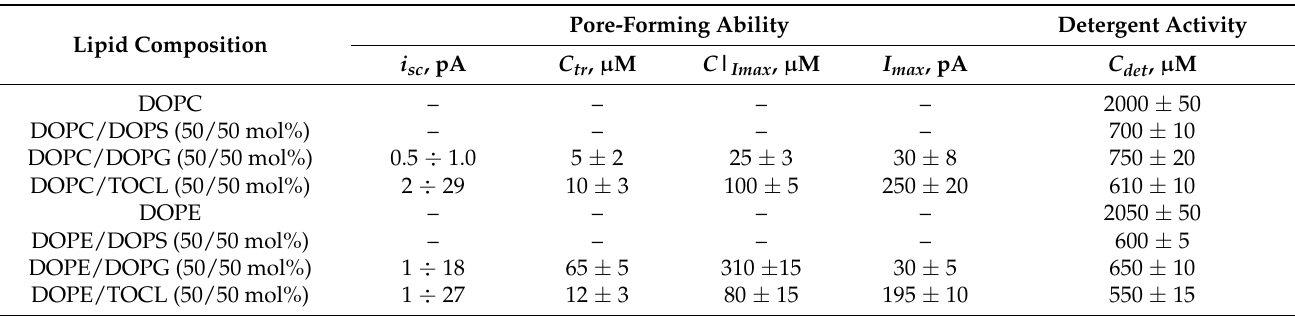
Table 1. The parameters characterizing the effects of nisin on the membrane of different phospho- lipid